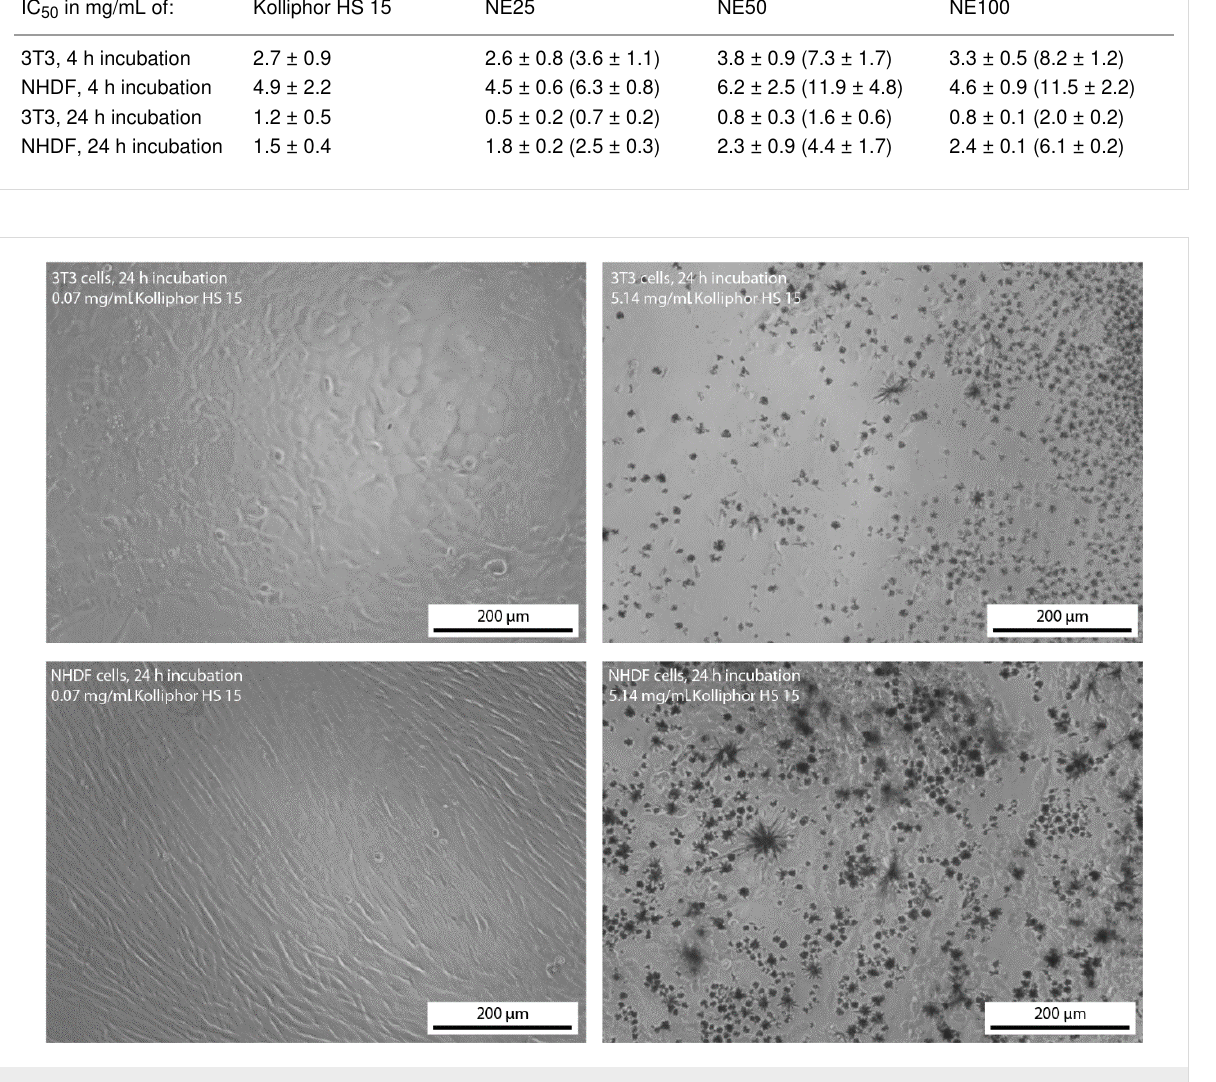
Figure 8: Morphology of the 3T3 and NHDF cells after 24 h incubation ion solutions with a concentration of the surfactant Kolliphor HS 15 of 0.07 and 5.14